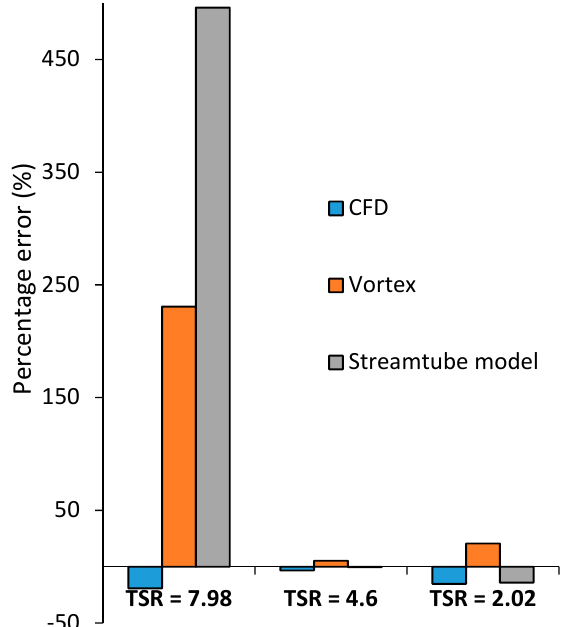
Figure 7. Error of the predicted power by CFD, stream-tube, vortex methods from the experiments at several tip speed ratios (TSR) [40].